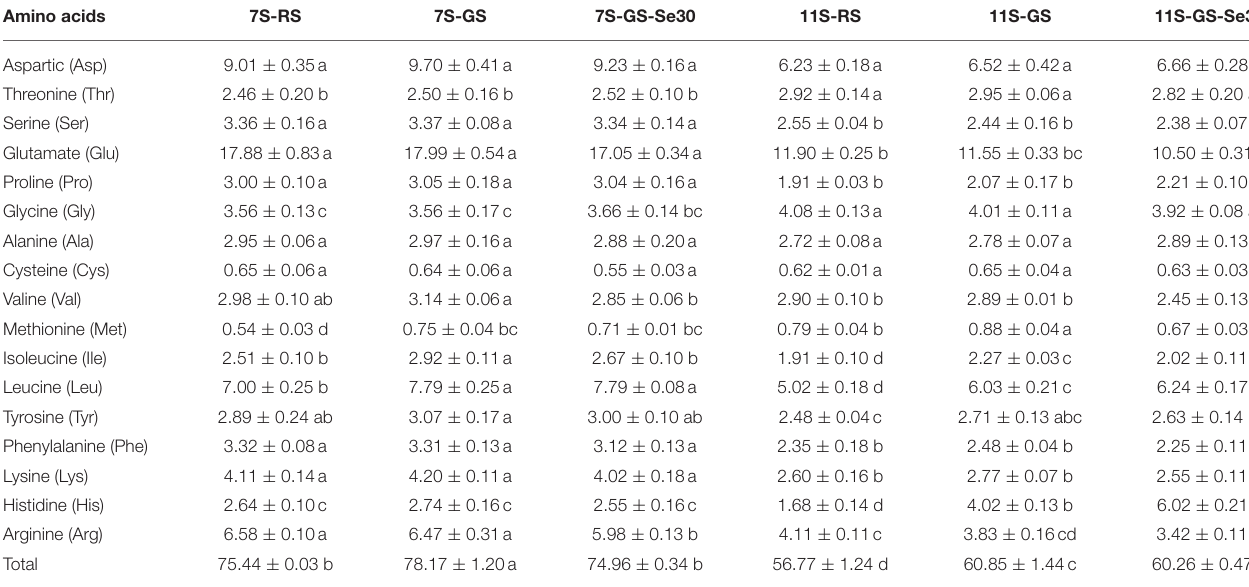
TABLE 2 | Total amino acid concentration during soybean germination with different concentrations of Se treatment (g/100g). Amino